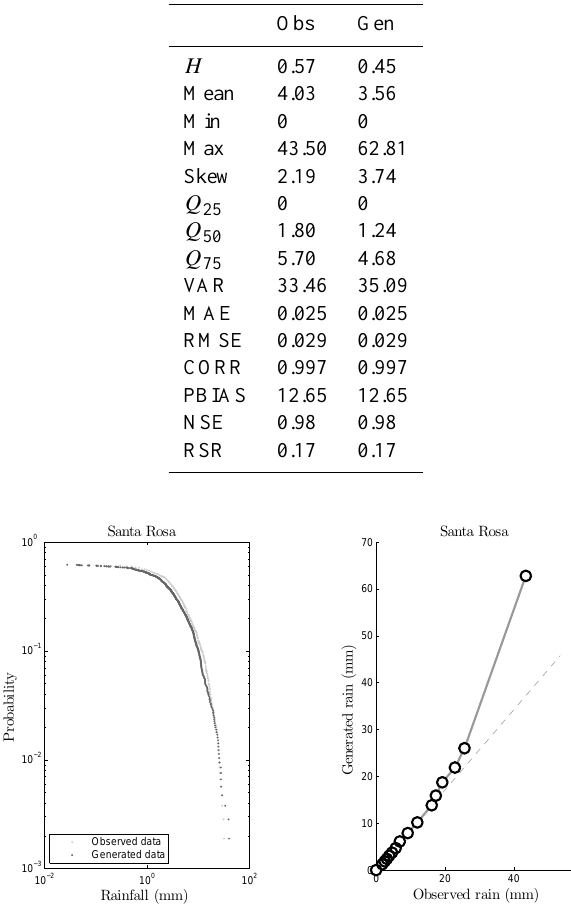
Figure 18. Exceedance probability and quantile–quantile plot of the Santa Rosa station during the dry season over an 8-year period. Comparison of observed, generated and corrected rainfall for the Santa Rosa